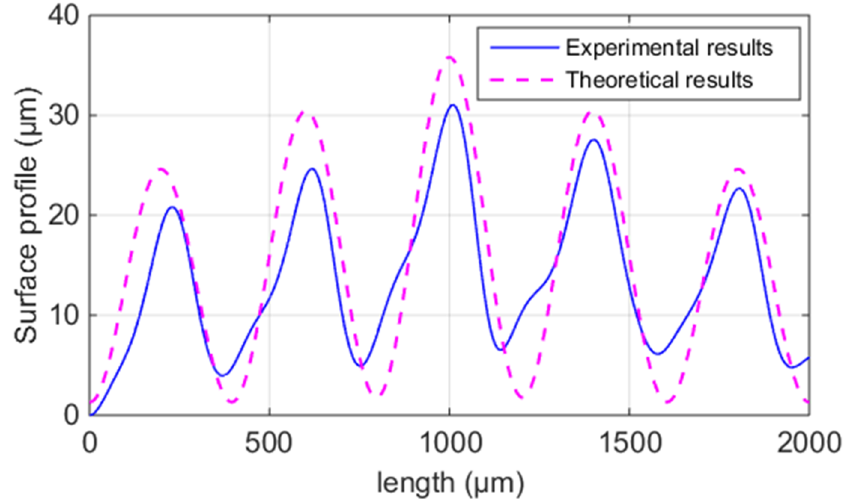
Figure 12. Theoretical and average experimental results of the surface profile of the ME samples vertical to the fiber direction.